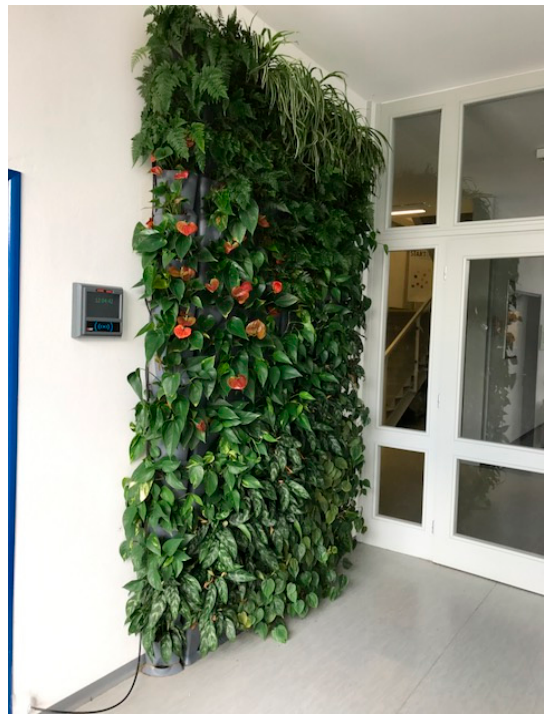
Figure 3. Look on a green wall after entering the laboratory hall.